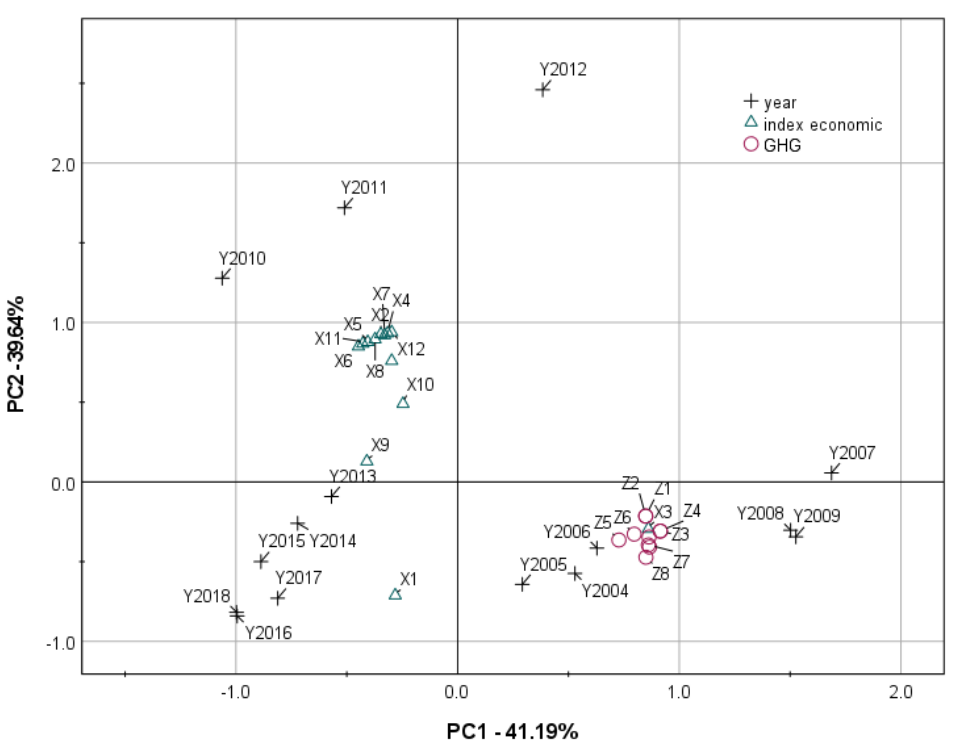
Figure 4. Relationships of locations of examined indices (Z 1 .... Z 10 ) of GHG emissions and economic indices (X 1 .... X 13 ) for field crop farms in the studied years (Y2004 .... Y2018) in the space of the first two components, PC1 and PC2.